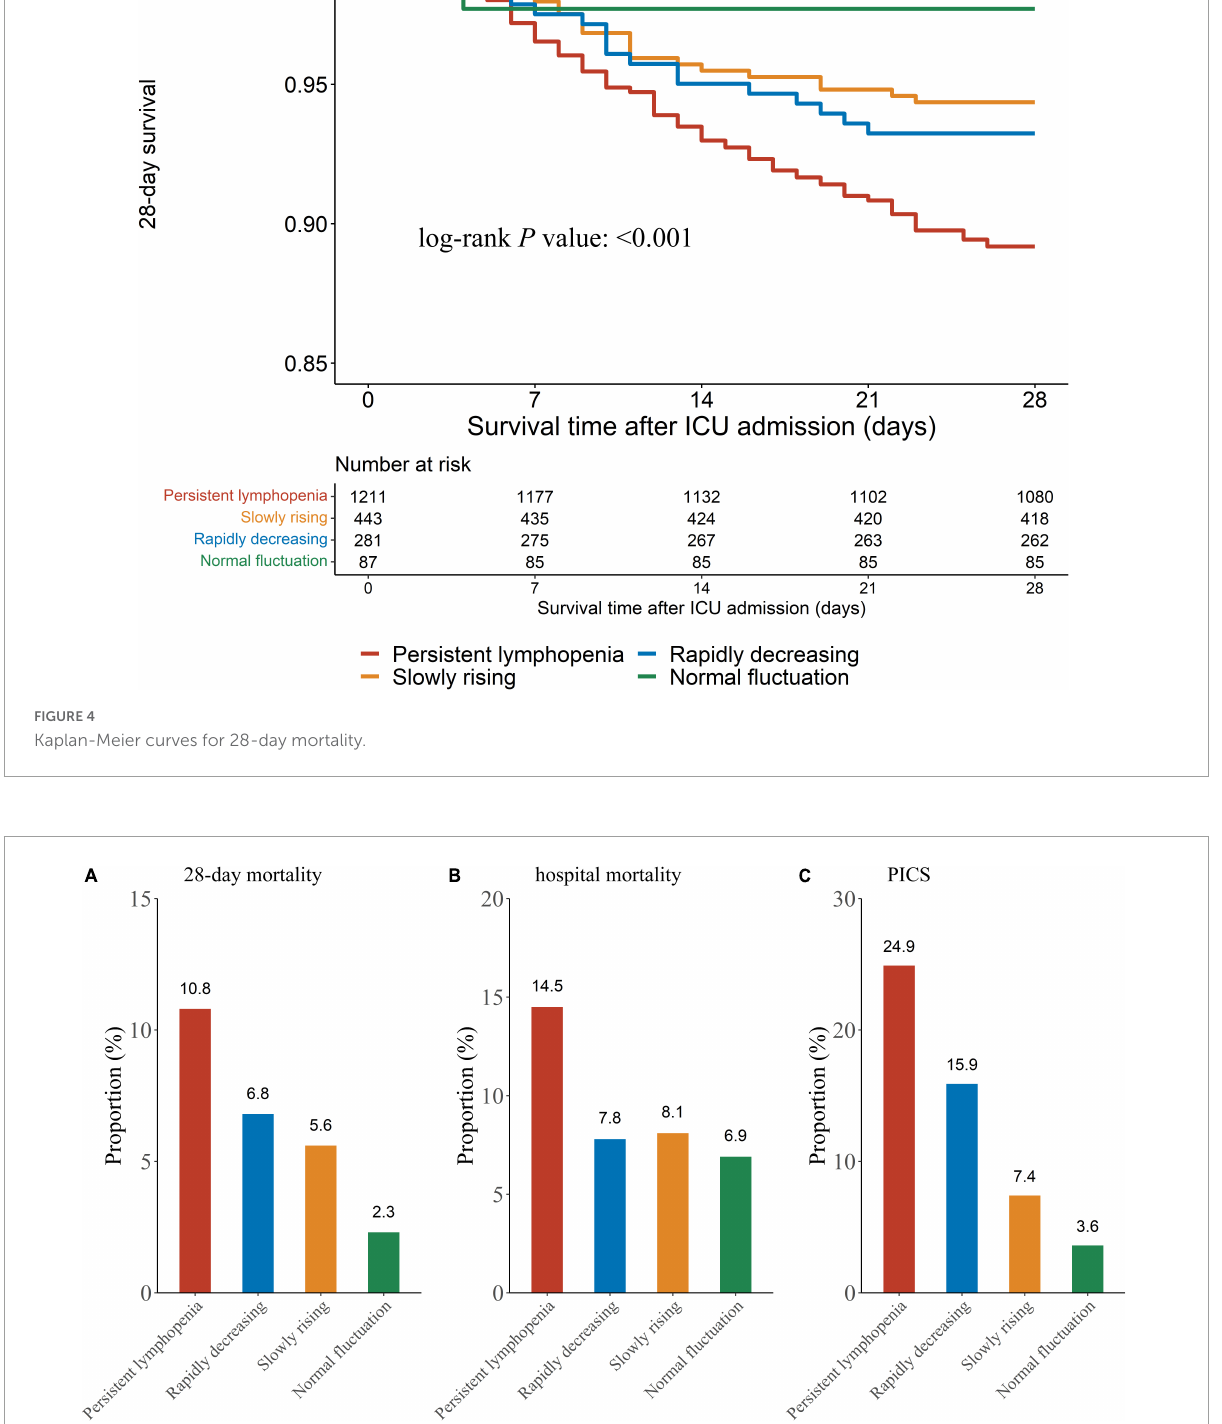
FIGURE5 Outcome comparison between the ALC trajectory endotypes. (A) Twenty-eight-day mortality; (B) hospital mortality; (C)